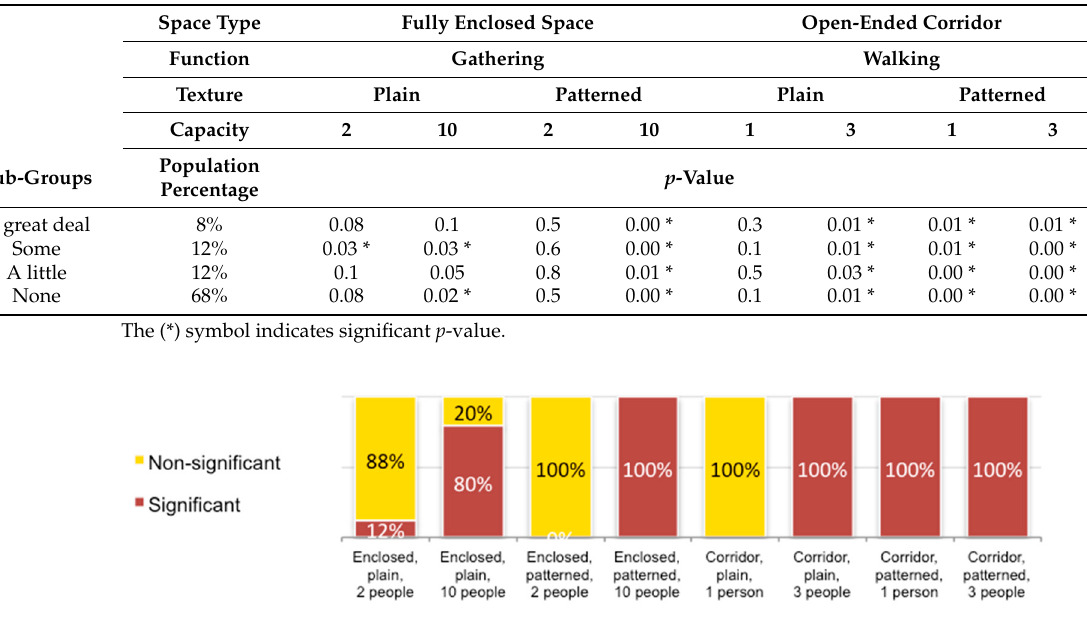
Figure 12. Percentage of participants with significant/non-significant size variations for each space in direct design experience with IVRIE perception